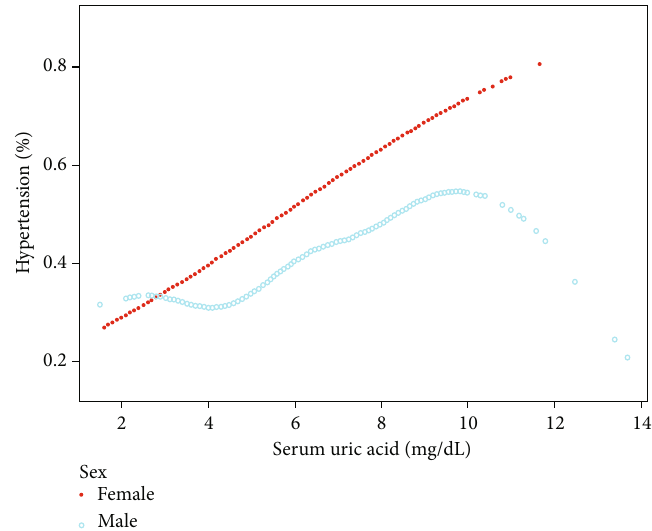
Figure 3: Association between sUA and HTN strati fi ed by sex. Age, race, income-poverty ratio, physical activity, smoking behavior, alcohol consumption, diabetes mellitus status, body mass index, total cholesterol, serum homocysteine, urine creatinine, blood urea nitrogen, and total calcium were